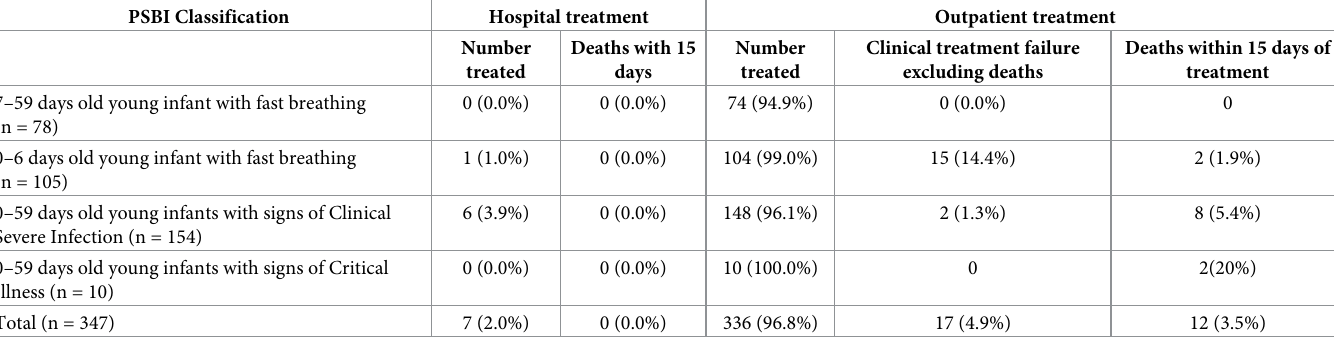
Table 3. Place of treatment and outcomes for young infants with signs of PSBI (N =